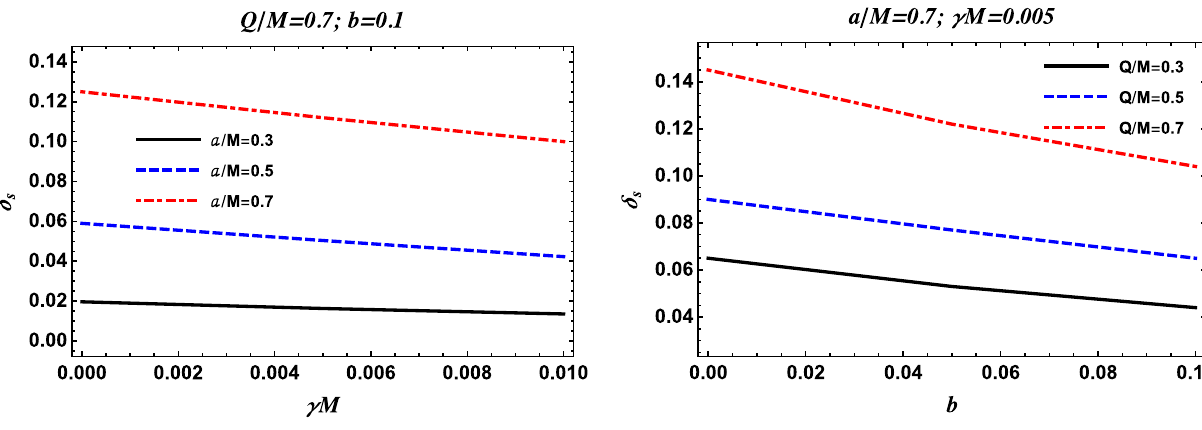
Fig. 5 Plots show the dependence of the distortion of the black hole shadow on the different spacetime